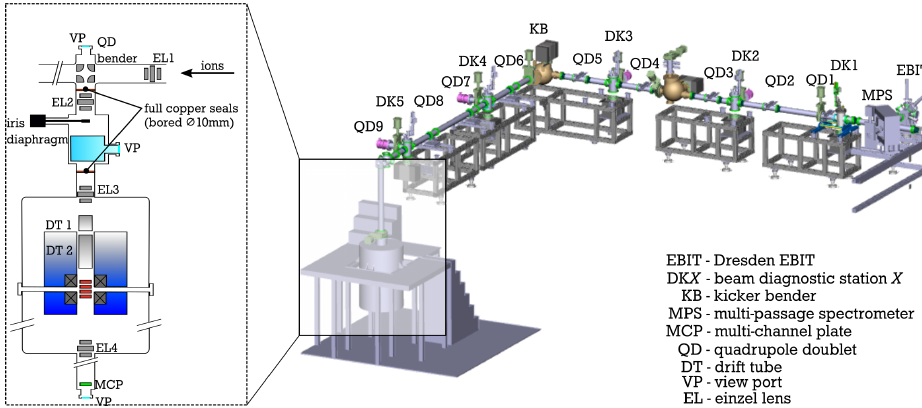
Figure 1. Schematic drawing of the HITRAP low-energy beamline ( right ) and a more detailed figure of the modified SPECTRAP beamline ( left